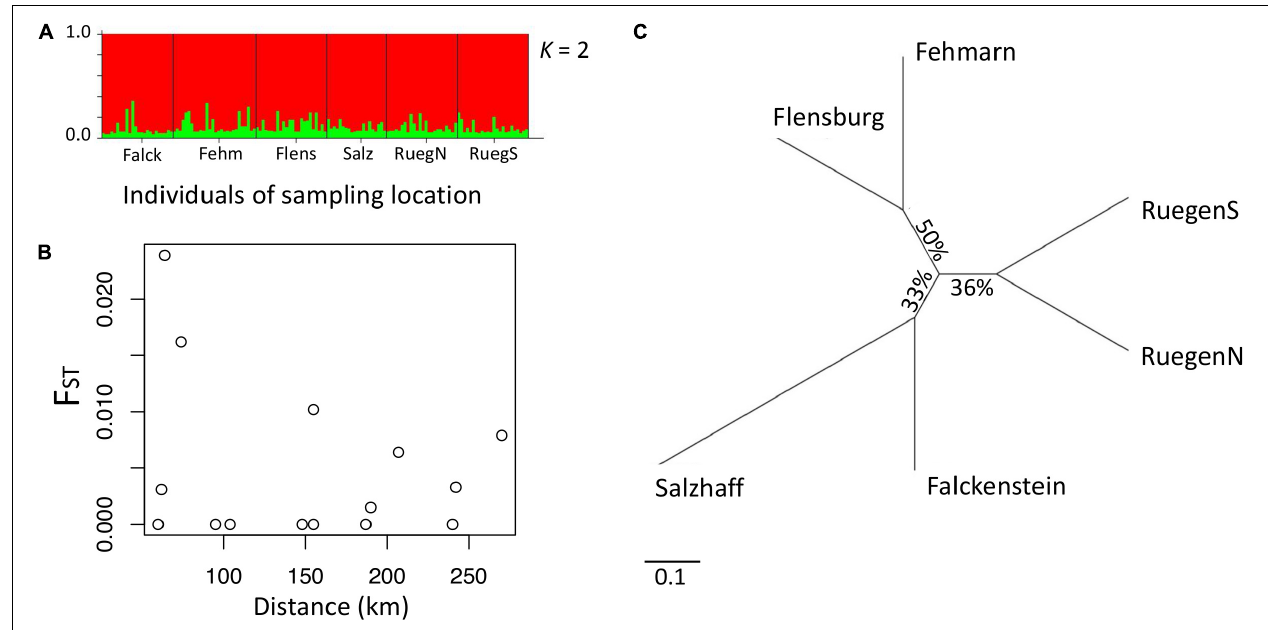
FIGURE 2 | Population structure of pipefish in the southern Baltic Sea . (A) STRUCTURE software results based on 11 microsatellite loci. Each individual is represented by a vertical line, which is colored according to the assigned groups ( K = 2). (B) Plotting pairwise F ST ( y -axis) against distance between sampling sites ( x -axis) does not reveal isolation by distance (waterway). (C) Unrooted phylogeographic PHYLIP tree. Distances indicate the relative divergence of microsatellite loci in pipefish between sampling sites. Scale bar represents nucleotide substitutions per site.